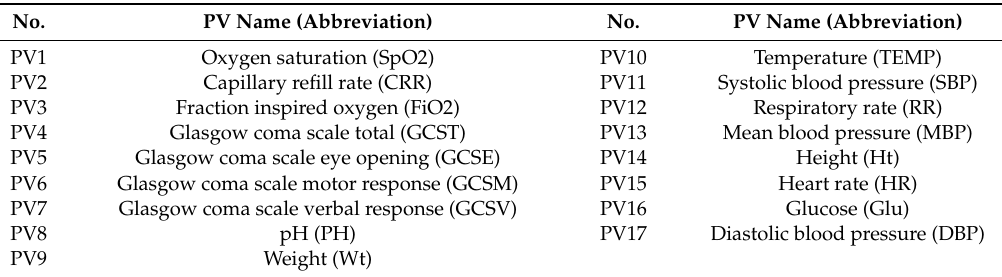
Table 2. The 17 PVs analyzed in this